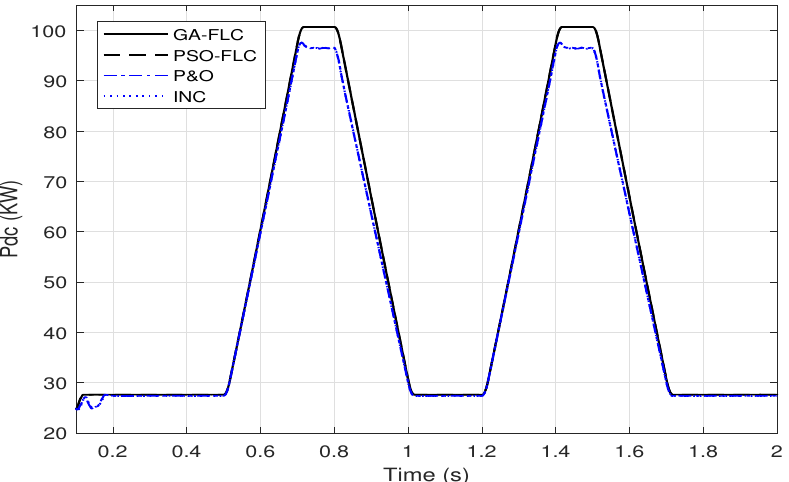
Figure 19. A Comparison of the output DC power of the PV array using GA-FLC, PSO-FLC, P&O and INC MPPT methods for a dynamic irradiance change based on EN50530